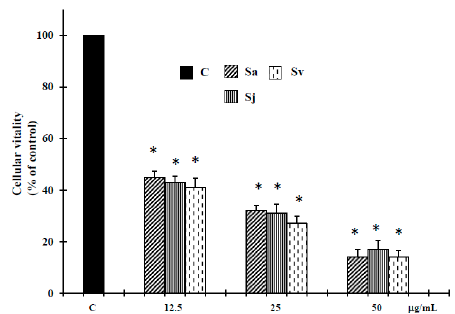
Figure 1. Cell growth, assayed using 3(4,5-dimethyl-thiazol-2-yl)2,5-diphenyl-tetrazolium bromide (MTT) test, of DU-145 cells untreated and treated with different concentrations of the essential oils from Sa, Sj and Sv for 72 h. The values are the mean ± standard deviation (SD) of three experiments performed in quadruplicate. * Significant vs. control untreated cells ( p < 0.001).